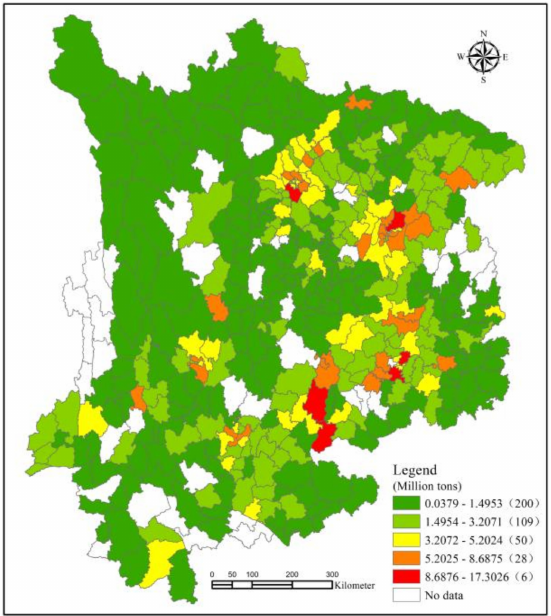
Figure 3. Spatial differences in carbon emissions in Southwest